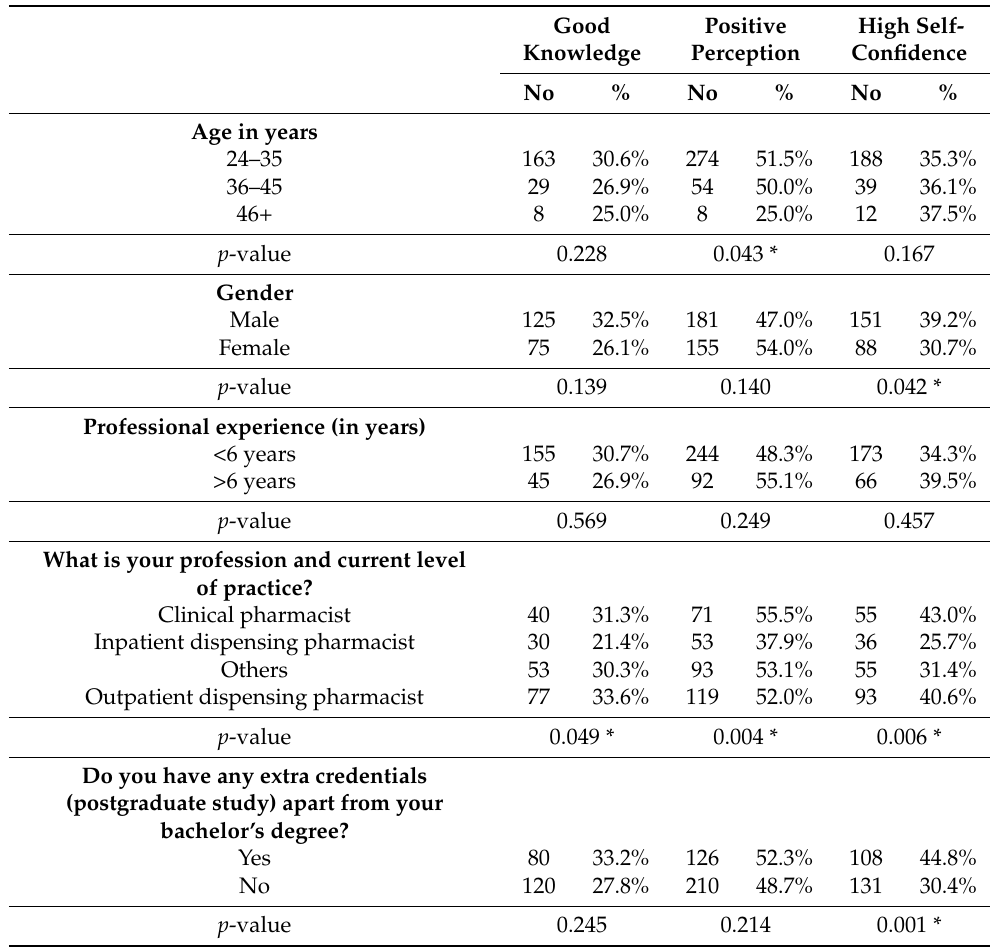
Table 4. Factors associated with pharmacists’ knowledge, perception, and self-confidence of PGx in Saudi